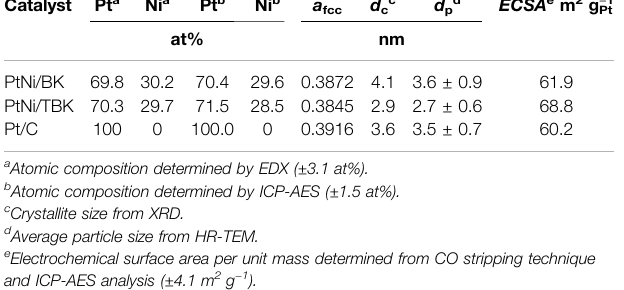
TABLE 3 | Characteristic parameters of the as-prepared catalysts. Catalyst Pt